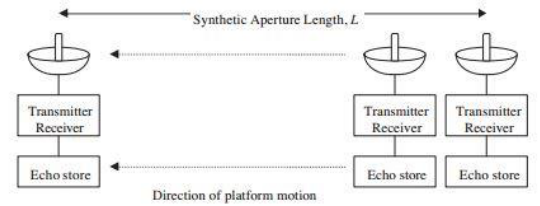
Figure 2. Synthetic aperture (Chan, Y.K., Koo, V.C., 2008.) Number of frequencies used to operate SAR shown in Table 1.